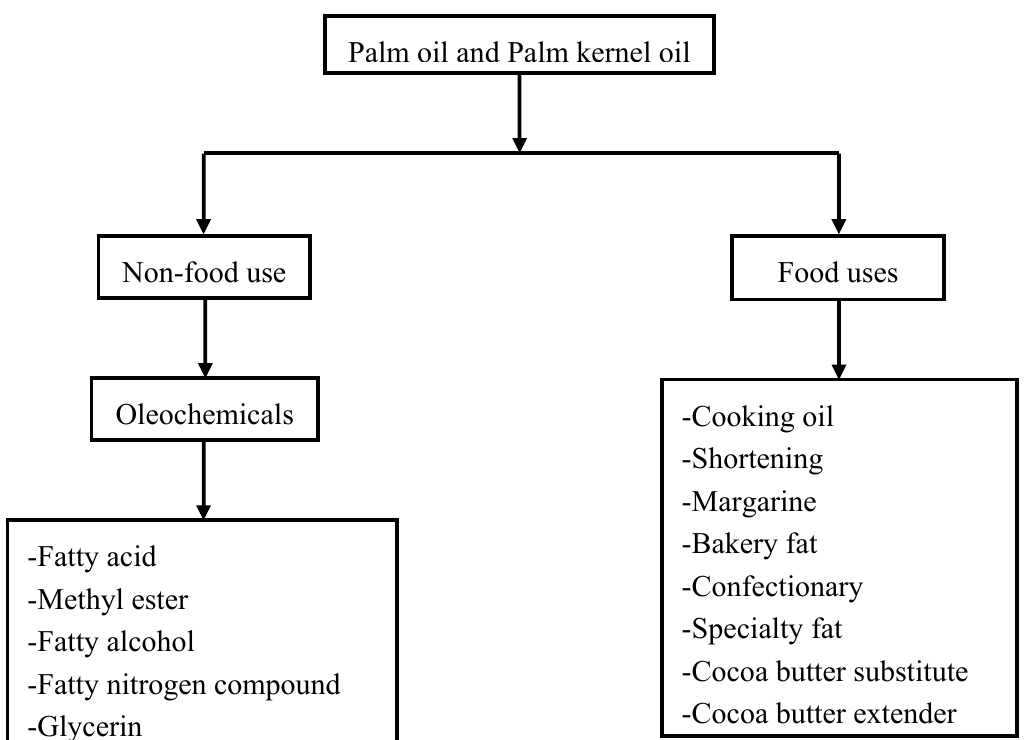
Figure 1. Flow diagram showing the usage of palm oil and palm kernel